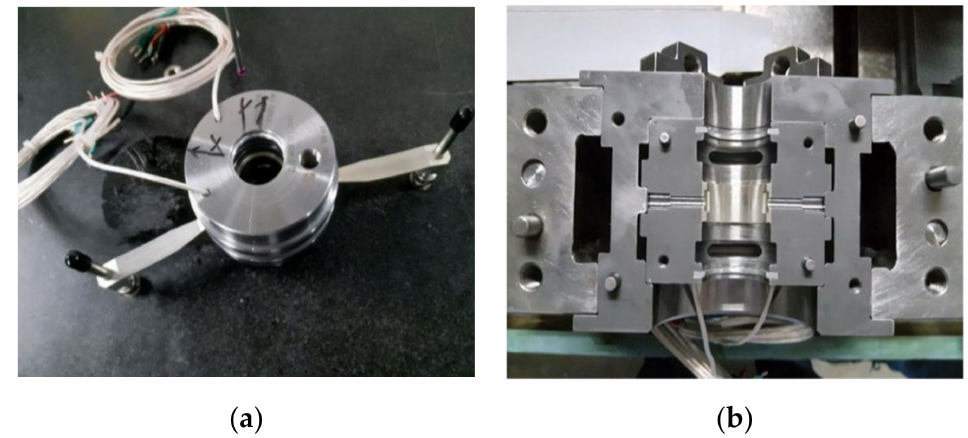
Figure 16. Cylindrical sliding bearings which are used in the experiment. ( a ) The actual picture of cylindrical sliding bearing; ( b ) Assembly face of the cylindrical sliding